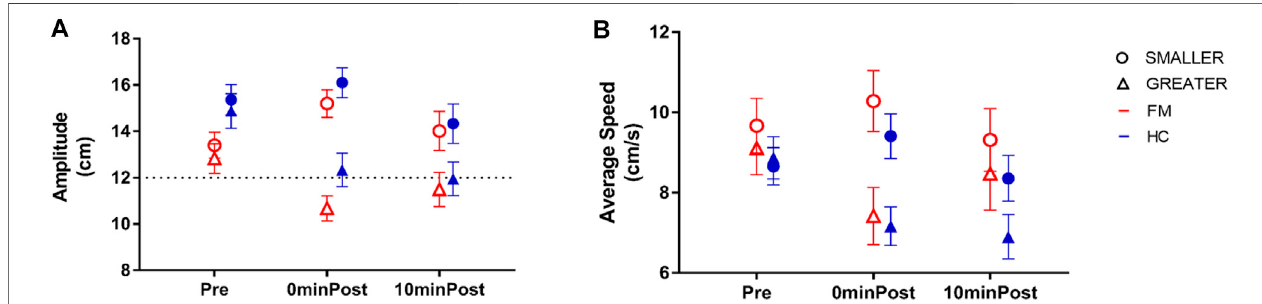
FIGURE6 | Adaptation to altered visual feedback (VF): After-effects acrossgroups. (A) As expected, Movement amplitude increased post-exposureto SMALLER VF condition (circles), but decreased post-exposure to GREATER VF condition (triangles). These changes were similar in subjects with fi bromyalgia (FM; red empty symbols)and healthycontrols(HC; blue fi lledsymbols) (B) Both groups adapted their AverageSpeed inaway thatisconsistent withthedisplayed VFcondition, but this adaptation was similar across groups. Error bars represent standard error of the mean.